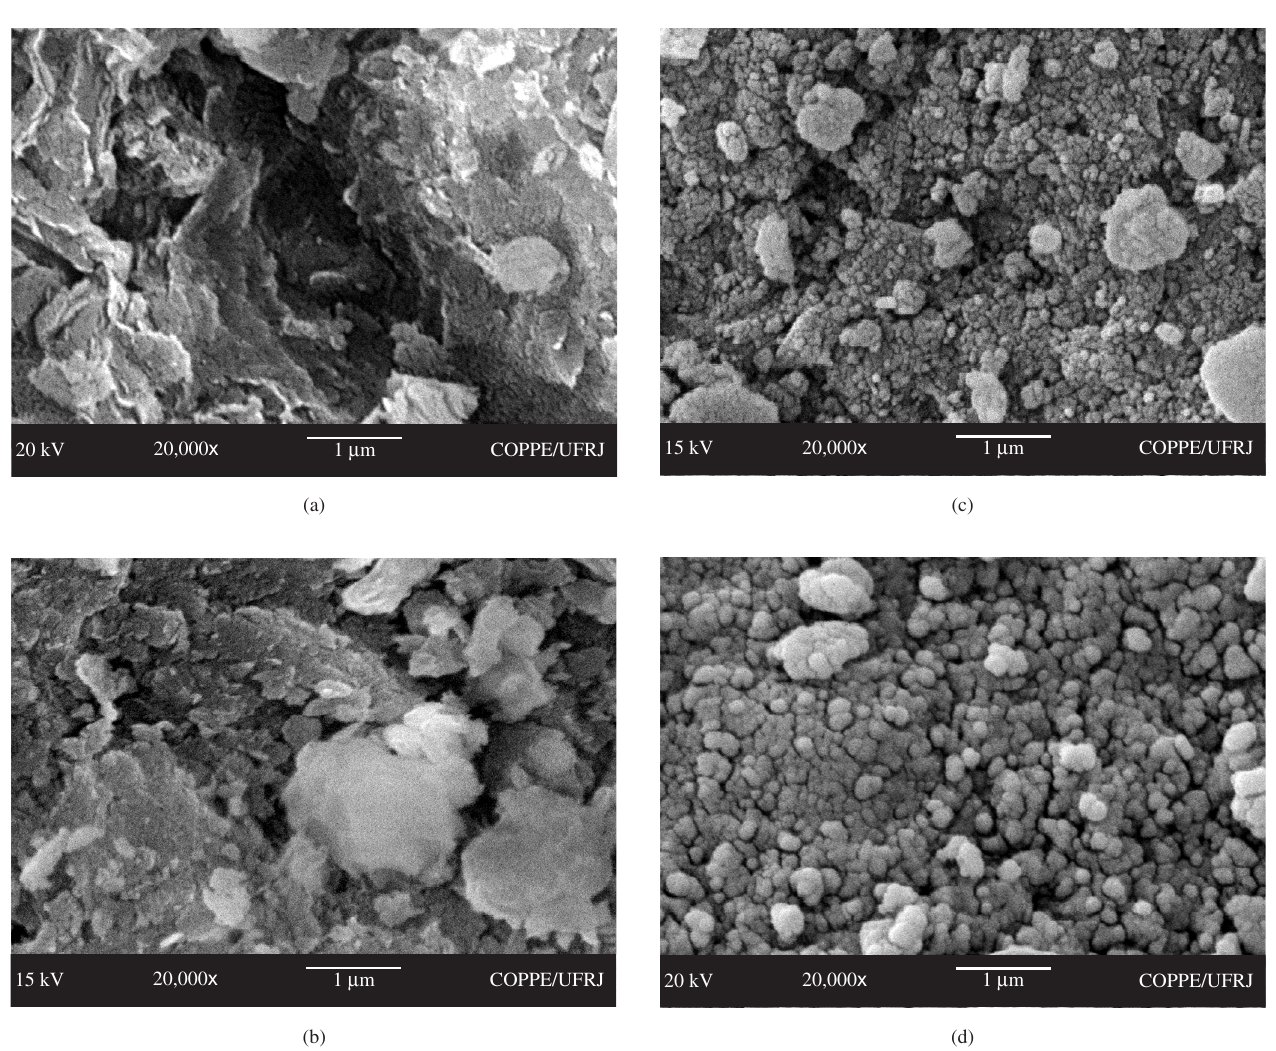
Figure 2. Effect of thermal treatment on the adsorbents morphology: a) TCO 626G clay without thermal treatment; b) TCO 626G clay with thermal treatment; c) Selexsorb CD alumina without thermal treatment; and d) Selexsorb CD alumina with thermal